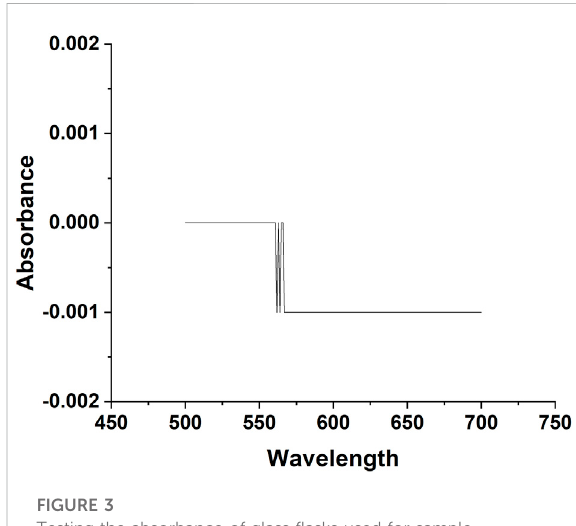
FIGURE 3 Testing the absorbance of glass fl asks used for sample detection from 500 to 700